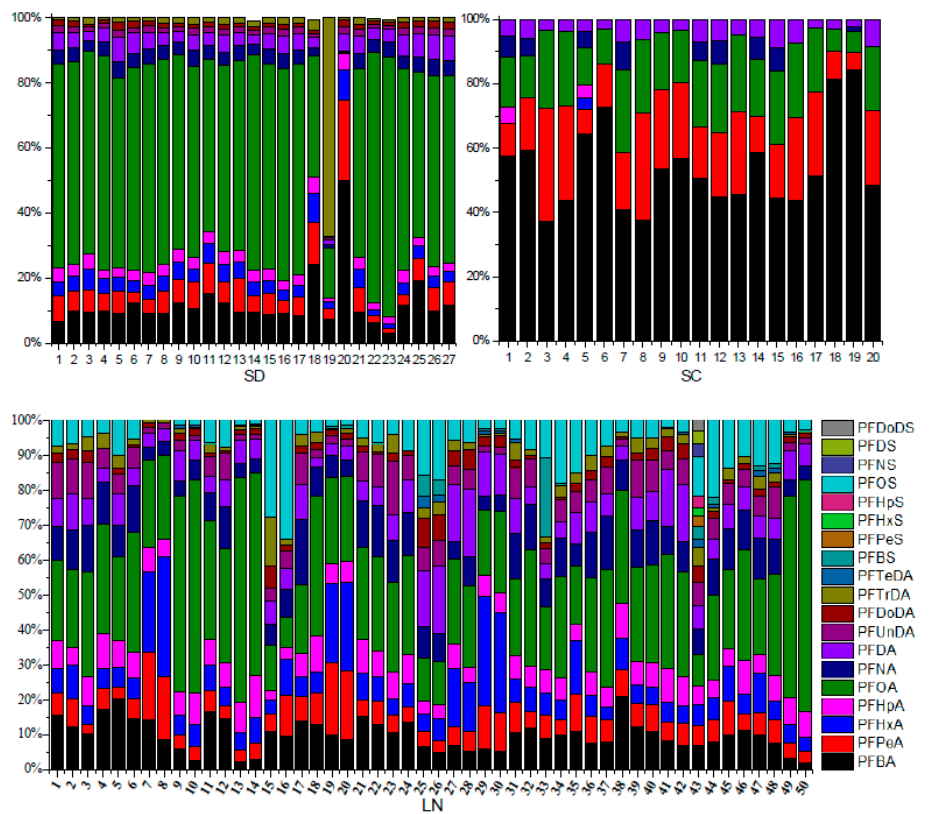
Figure 4. The composition of PFAA compounds in soil samples from Shandong (SD), Sichuan (SC) and Liaoning (LN) provinces. The odd numbers represent the top soil and the even ones represent deep soil for SD and LN.